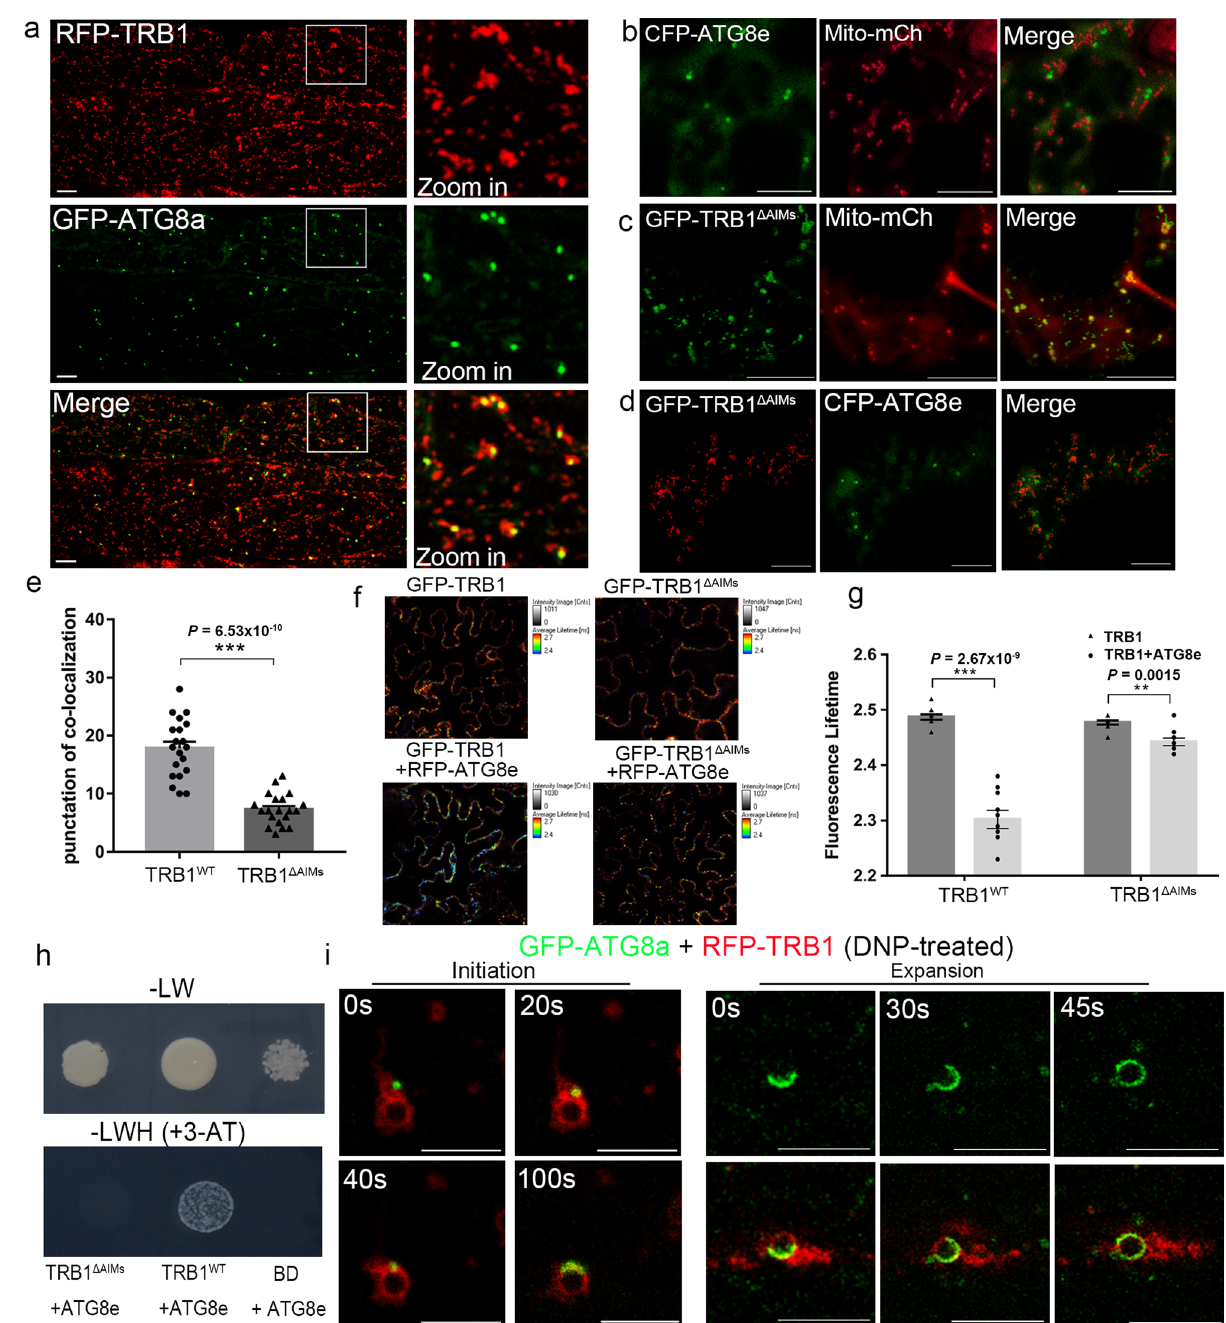
Fig.5|TRB1interactswithATG8throughtheATG8interactingmotif(AIM).a In Arabidopsisstablytransformed